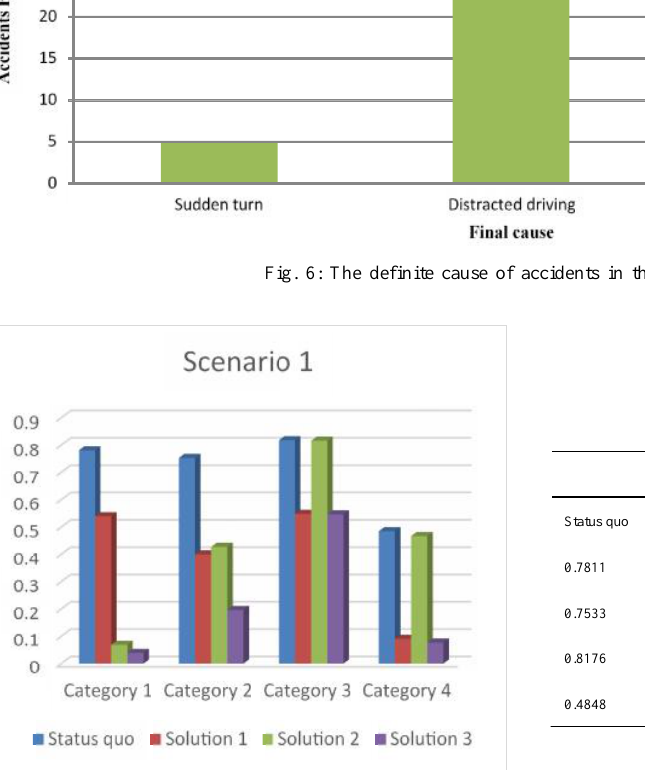
Fig. 7: The results of Vehicle-motorcycle accident probabilities after the adoption of the proposed solutions at Qods